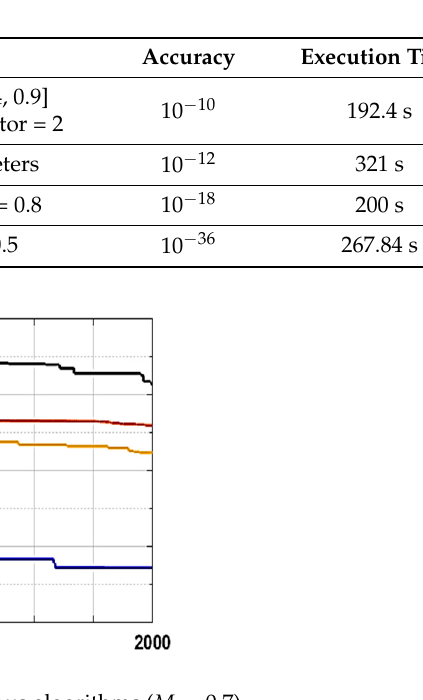
Figure 7. FF at different iterations number of various algorithms ( M i = 0.7). Table 2. Comparison among different algorithms for M i = 0.7, 2000 iterations, population size of 70 and 10 trial runs in an 11-level